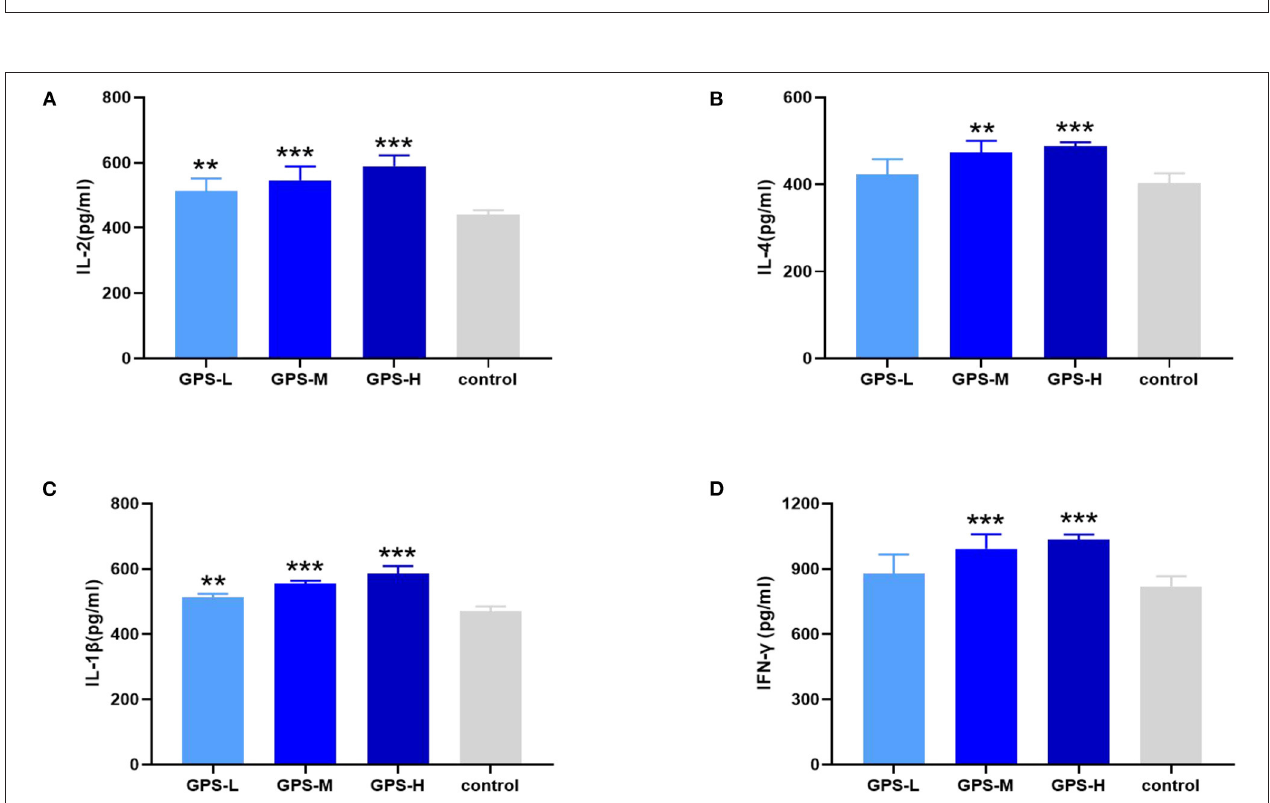
FIGURE 3 | After the laying hens were orally administered GPS for 14 days, the changes of cytokines in the serum of laying hens were determined by ELISA.GPS enhances the expression of (A) IL-2, (B) IL-4, (C) IL-1 β , and (D) IFN- γ . * P < 0.05, ** P < 0.01, and *** P < 0.001, all relative to the saline (control) group.